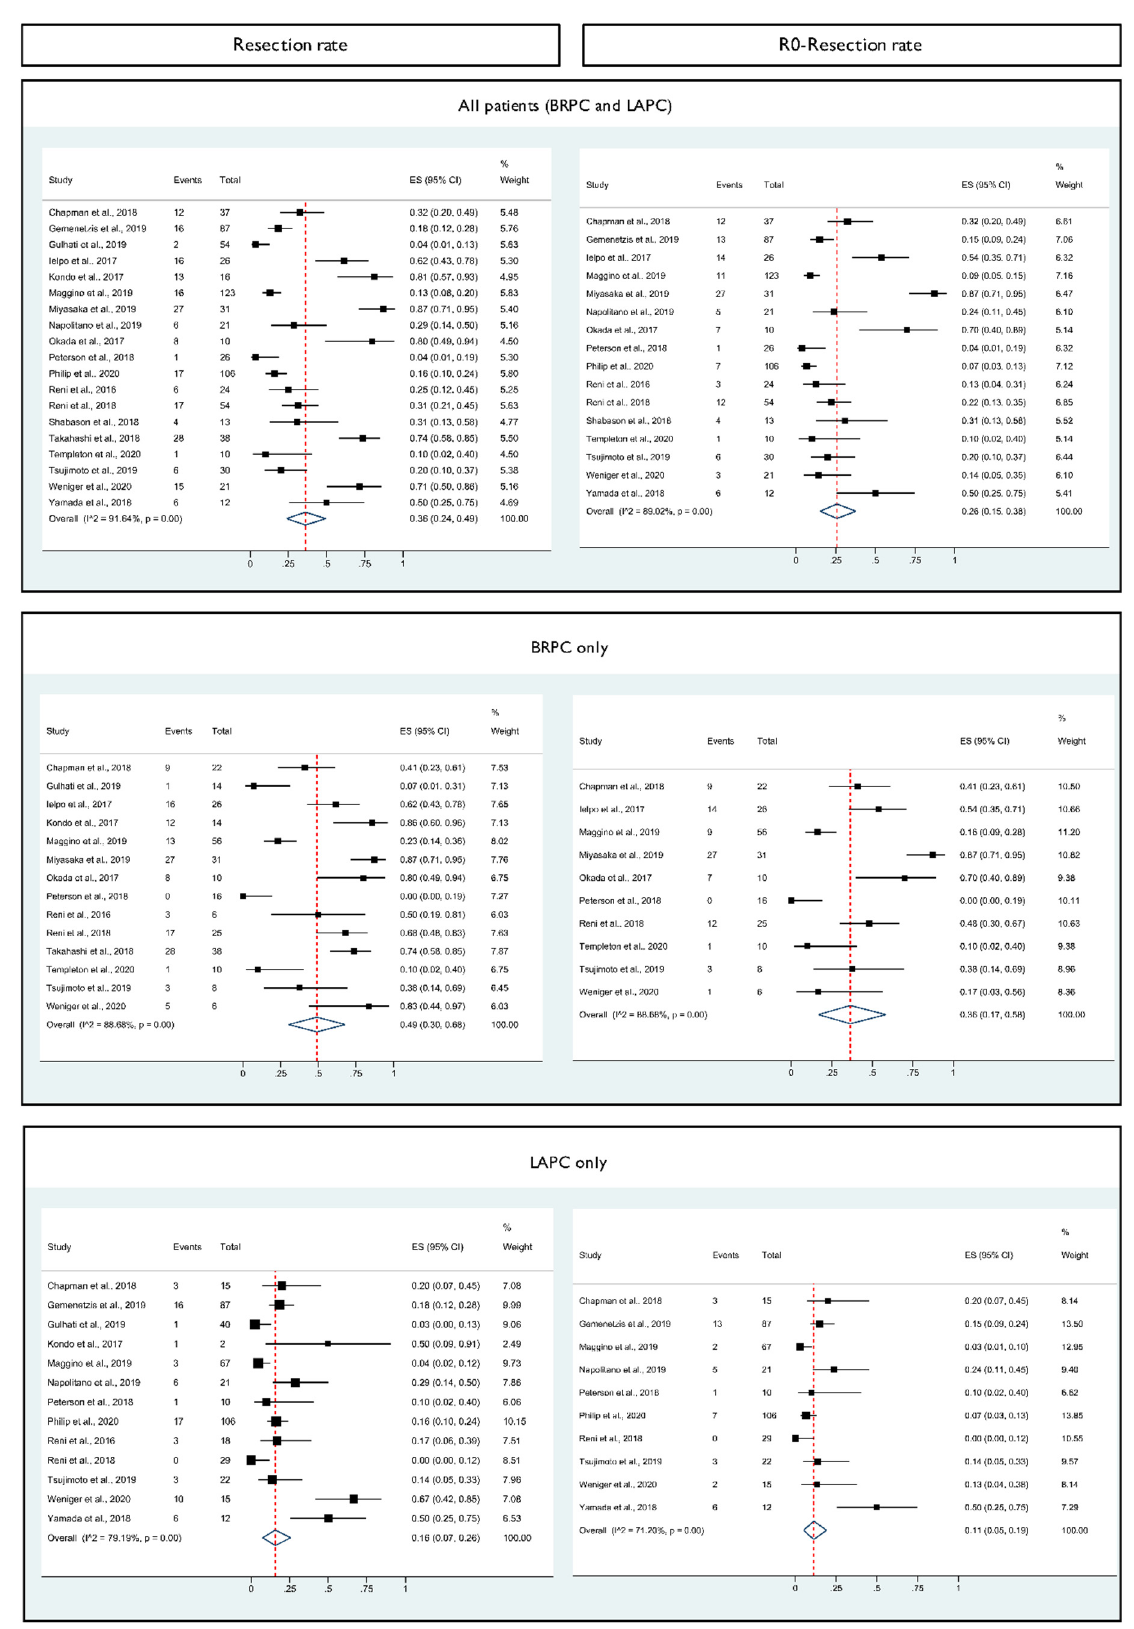
Figure 2. Forest plots showing the pooled proportions of resections and R0 resections (defined as absence of tumor at the margin or a minimum distance between tumor and margin of >1 mm) of all patients ( n = 739, refs. [26,28–31,33–46])